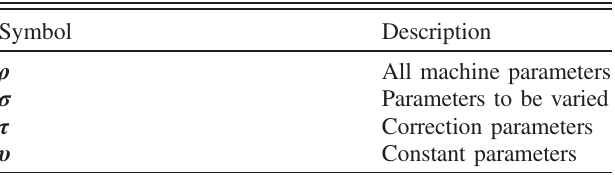
All machine parameters